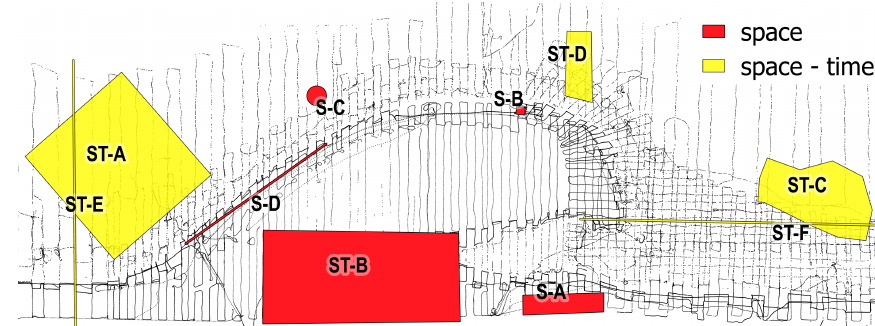
Figure 5: The spatial representation of the queries used within the benchmark